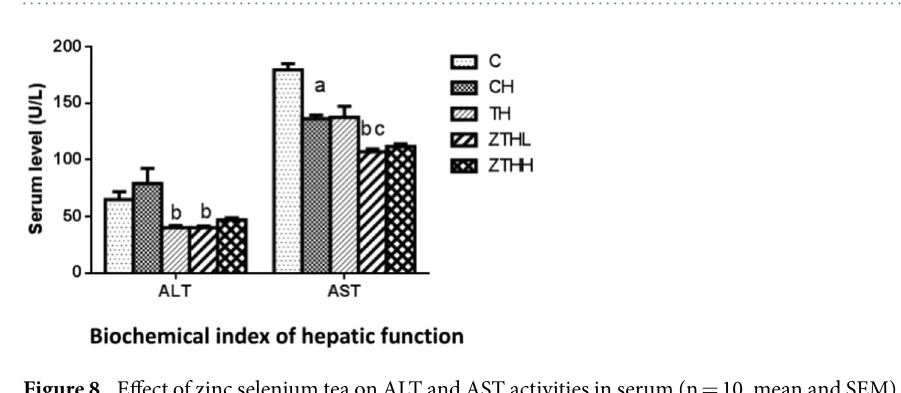
Figure 8. Effect of zinc selenium tea on ALT and AST activities in serum (n = 10, mean and SEM) in experimental groups. a Vs C-group, p < 0.05; b vs CH-group, p <